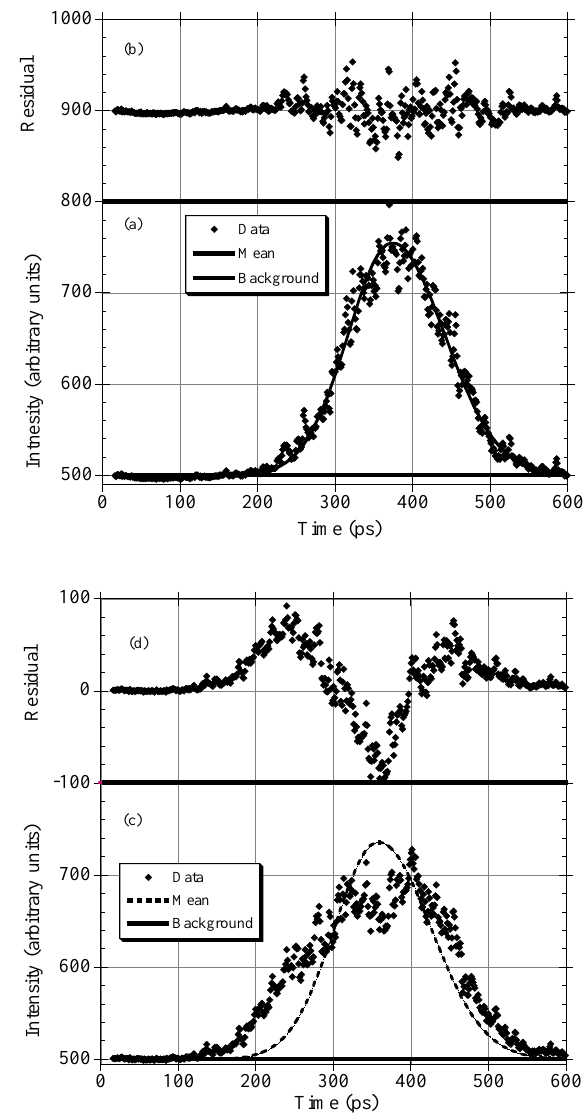
FIG. 13. The CESR electron bunch distributions when the rf phase is modulated at the frequency of 369.9 kHz and signal generator voltage amplitudes of (a) 2 20 dBm and (b) 1 10 dBm. The residuals from the mean distribution are plotted above the figure for the signal generator voltages of (c) 2 20 dBm and (d) 1 10